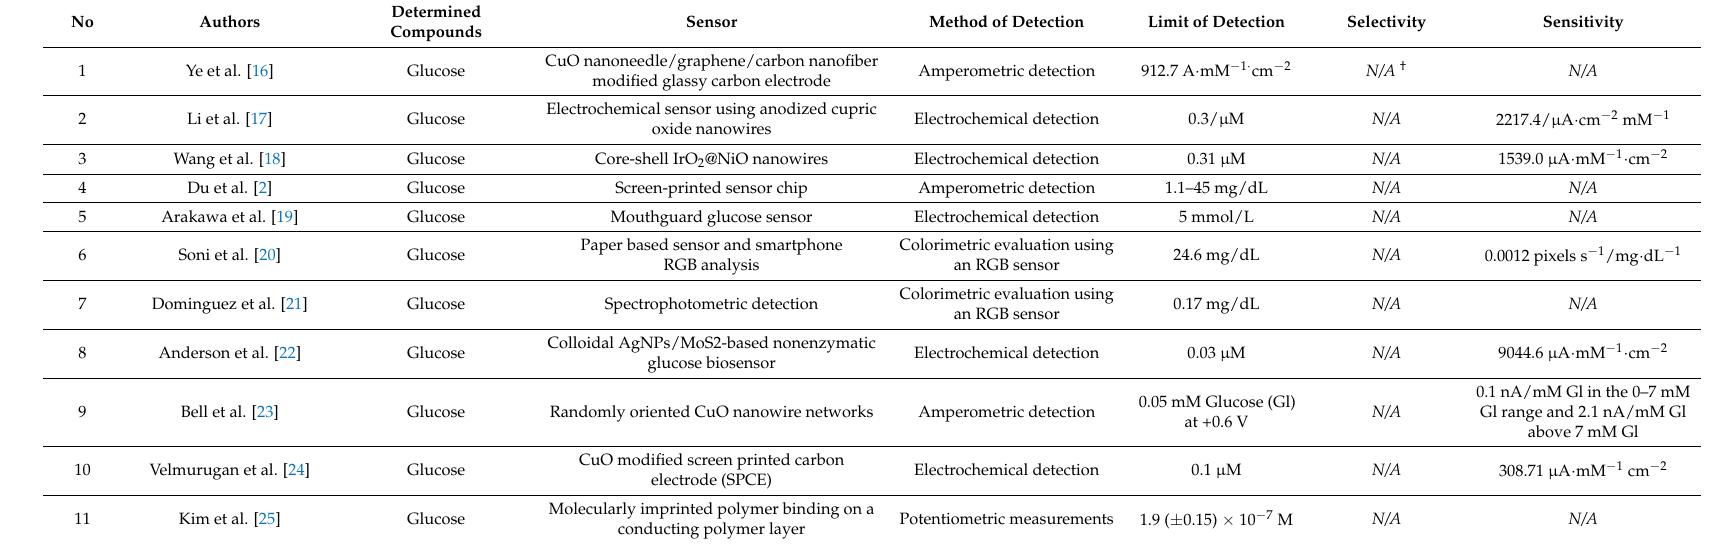
Table 2. The characterization information on the sensors from the final eligible